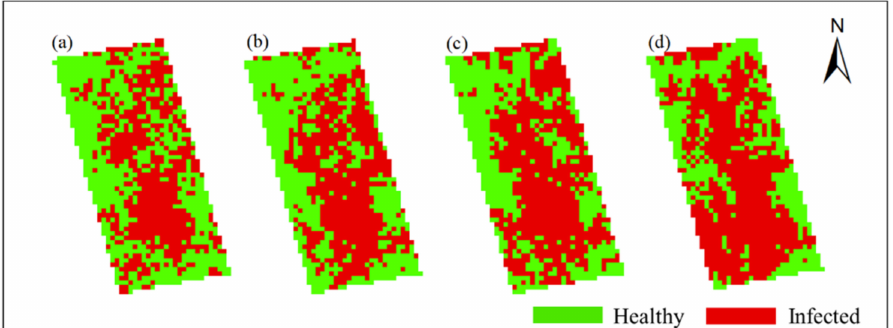
Figure 12. Spatiotemporal distribution of occurrence information of rice false smut in Plot